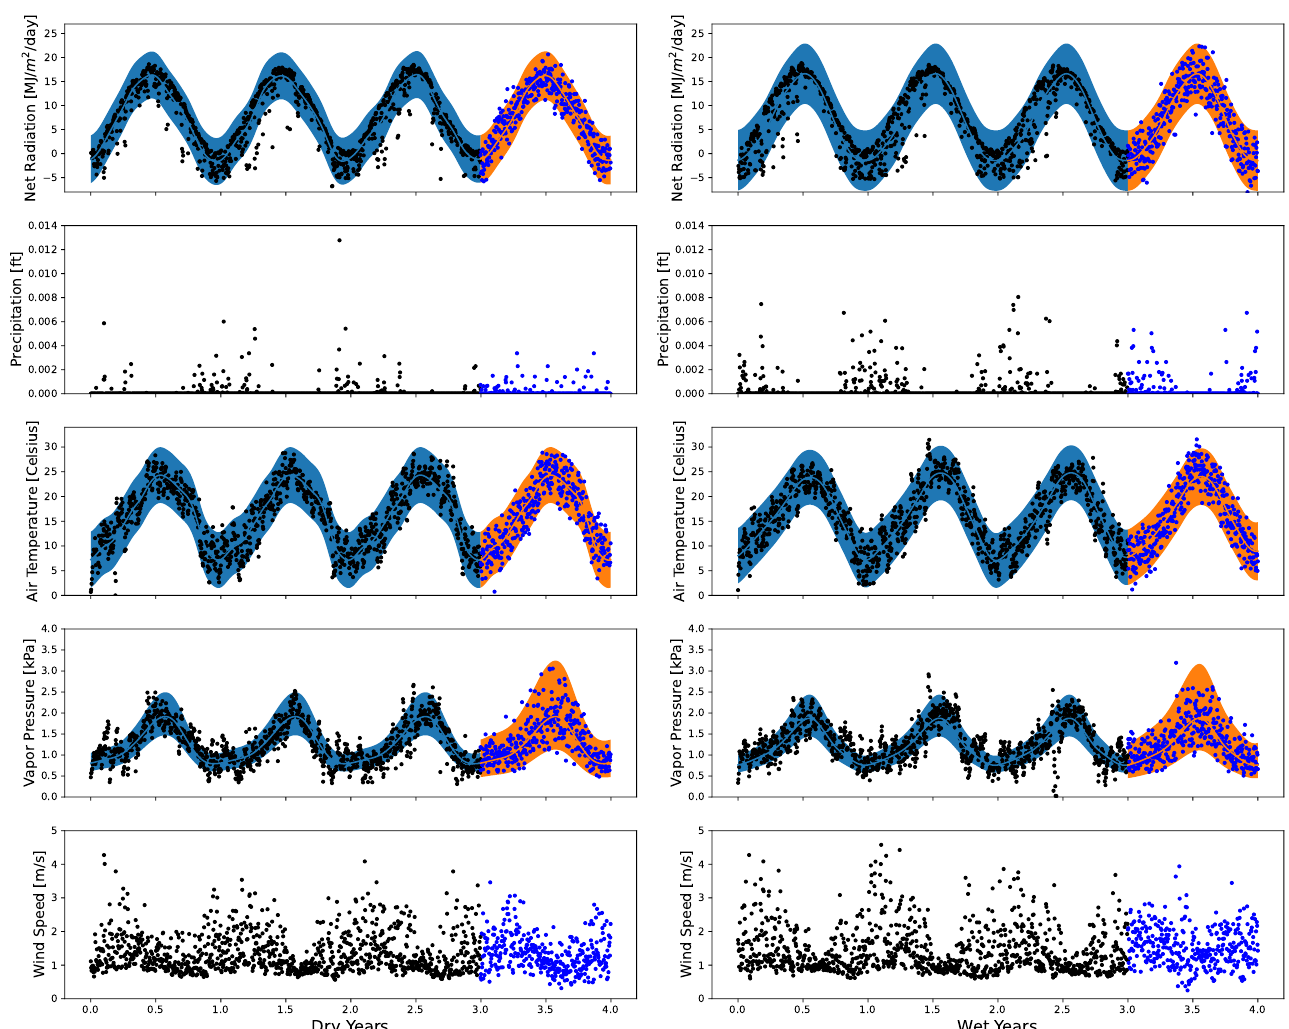
Figure 1. Training and forecast data for environmental parameters. The training data (in black) were chosen from a sequence of dry or wet years according to the SPI in Figure 2. The forecast is shown in blue dots, with the envelopes around the data representing 2 standard deviations of the mean. The key distinction between these model training scenarios is the seen in the wet years having noticeably more precipitation